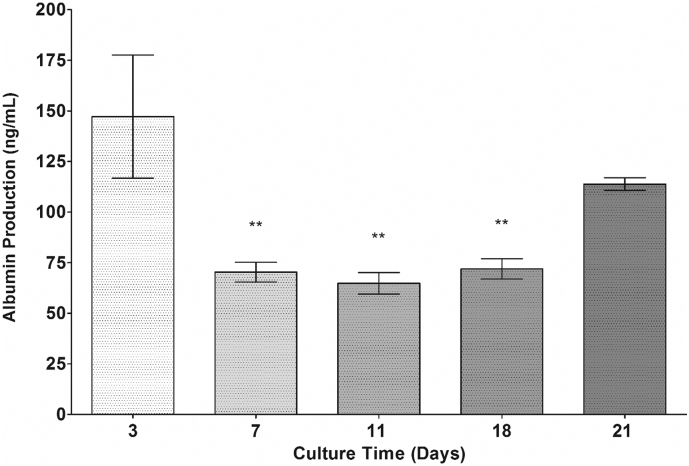
Albumin production from 5000-cell spheroids. Spheroids were produced from 5000 cells on liquid-overlay plates. Albumin production was quantified in supernatant samples over a 21 day period. Data are represented as mean ± SEM (n = 3 in triplicate). Albumin production was considered statistically significantly lower for day 7 and 11 time points compared to day 3 by One-way ANOVA, ⁎⁎p < .01. There was no statistically significant difference in albumin production between day 3 and day 21.